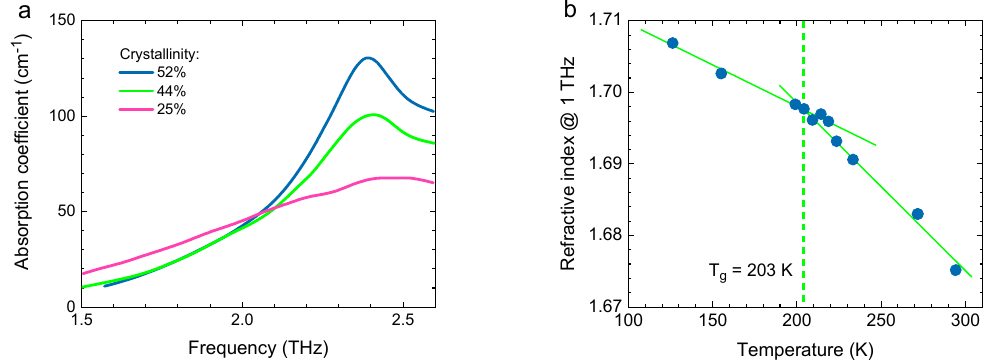
Figure 5. ( a ) Absorption spectrum of three samples of polybuthylene terephathalate (PBT) with di ff erent degrees of crystallinity. ( b ) Temperature-dependent refractive index of polyoxymethyllene (POM). The glass transition temperature can be determined from the intersection of the two linear slopes. Figures adapted from [32], courtesy of S. Wietzke, Continental AG.